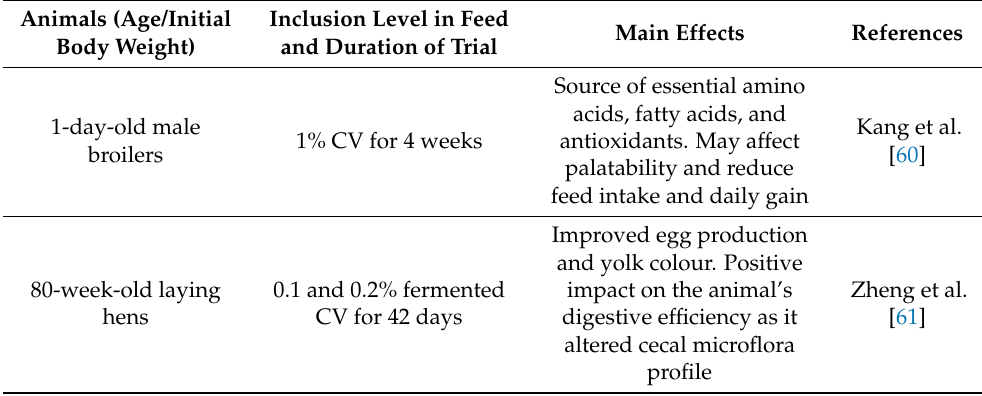
Table 4. Summary of the main effects of inclusion of Chlorella vulgaris (CV) biomass or Chlorella by-products in poultry